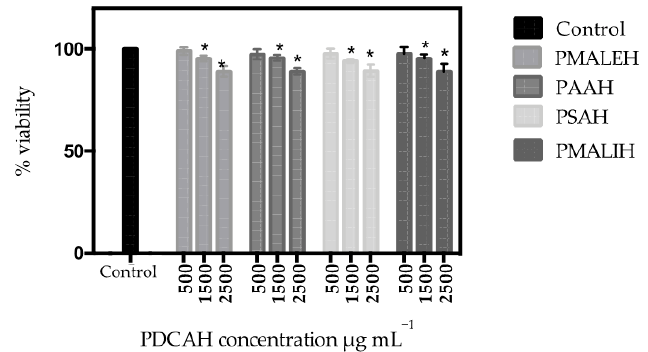
Figure 7. Percentage of cell viability obtained from the MTT assay of the L929 fibroblast cells with respect to a negative control (without PDCAH). n = 3, * = p < 0.05 with respect to the control.